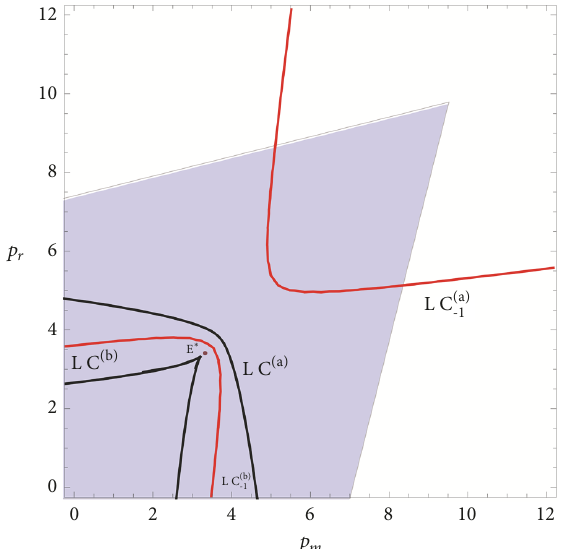
Figure 8: The basin of attraction when 𝛼 1 = 0.4, 𝛼 2 = 0.1